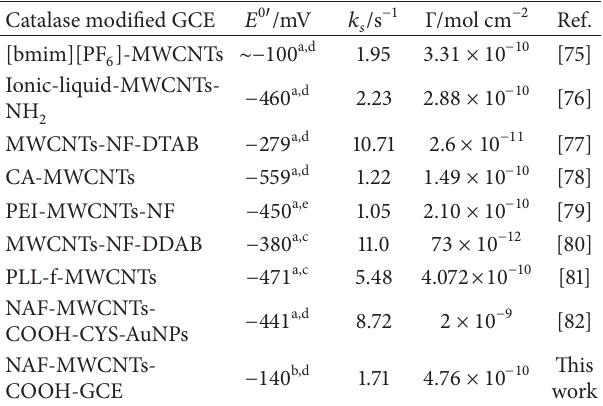
Table 3: Comparison of electrochemical parameters of the catalase modified glassy carbon electrodes by using MWCNTs recently developed for H 2 O 2